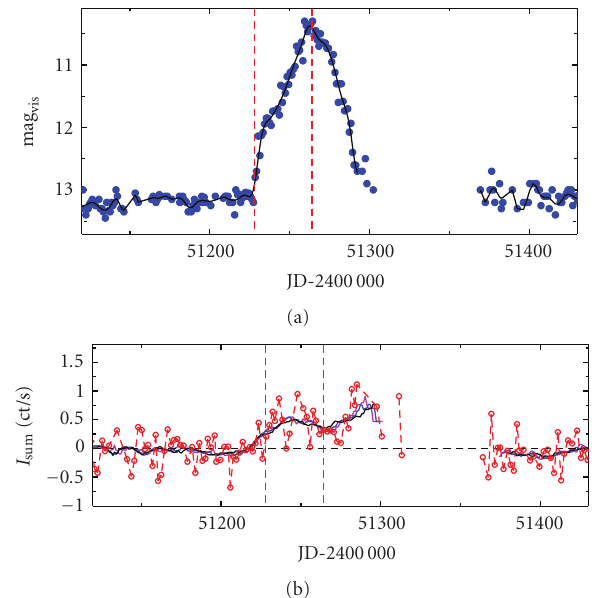
Figure 2: Relation between the outburst light curves of GK Per in the optical (a) and X-ray (1.5–12 keV) (b) passbands. The optical data are from the AFOEV database, while the X-ray ones were obtained by ASM/RXTE. The smooth line in (a) represents the fit by the code HEC13. The thick lines in (b) denote the smoothing by the moving averages. The dashed vertical lines mark the times of the onset and the maximum light of the outburst in the optical region. Adapted from [6]. See Section 2.3 for details.